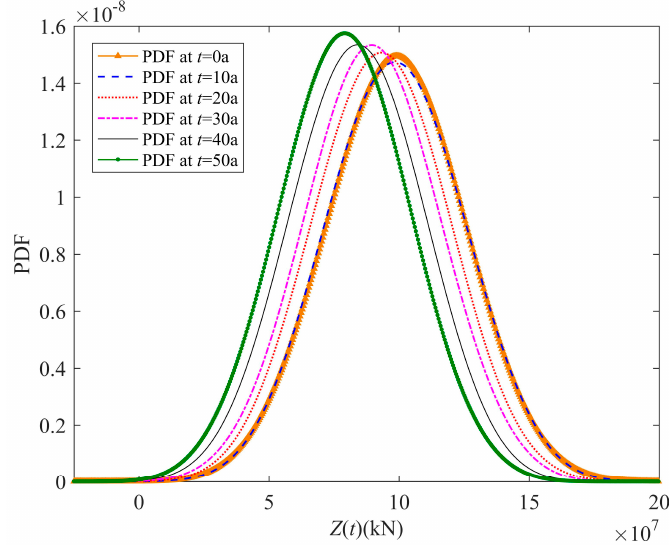
Figure 6. PDF for different tr.